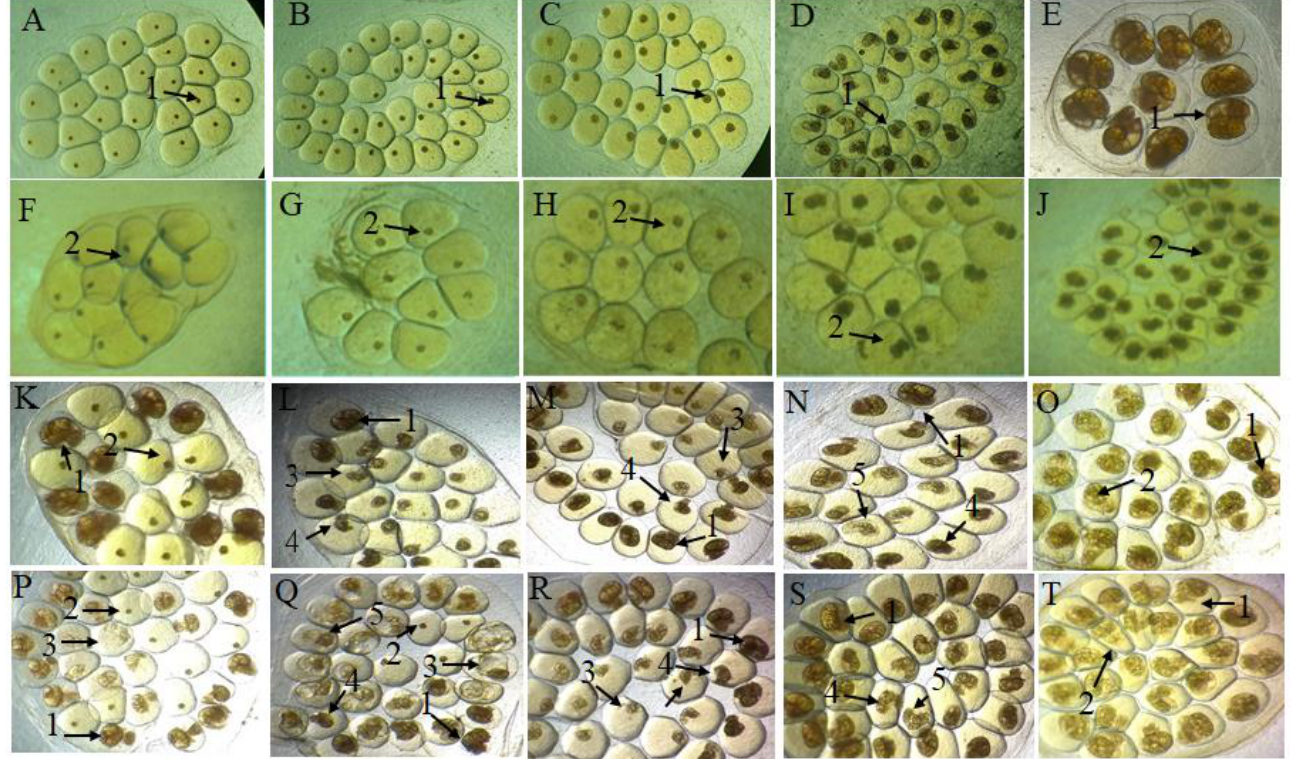
Figure 3. Embryonic stages of B. glabrata and exposure to saline extract and fraction for 24 h. Negative control in blastula stages ( A ); gastrula ( B ); trochophore ( C ); veliger ( D ) and hippo stage ( E ); embryos exposed to the positive control niclosamide, 1.0 µg/mL, ( F – J ); embryos exposed to saline extract at different concentrations ( K – O ); embryos exposed to the fraction at different concentrations ( P – T ). 1: Live embryo; 2: dead embryo; 3: hydropic embryo; 4: embryo with developmental delay; 5: malformation of the shell. All images with 40× magnification.